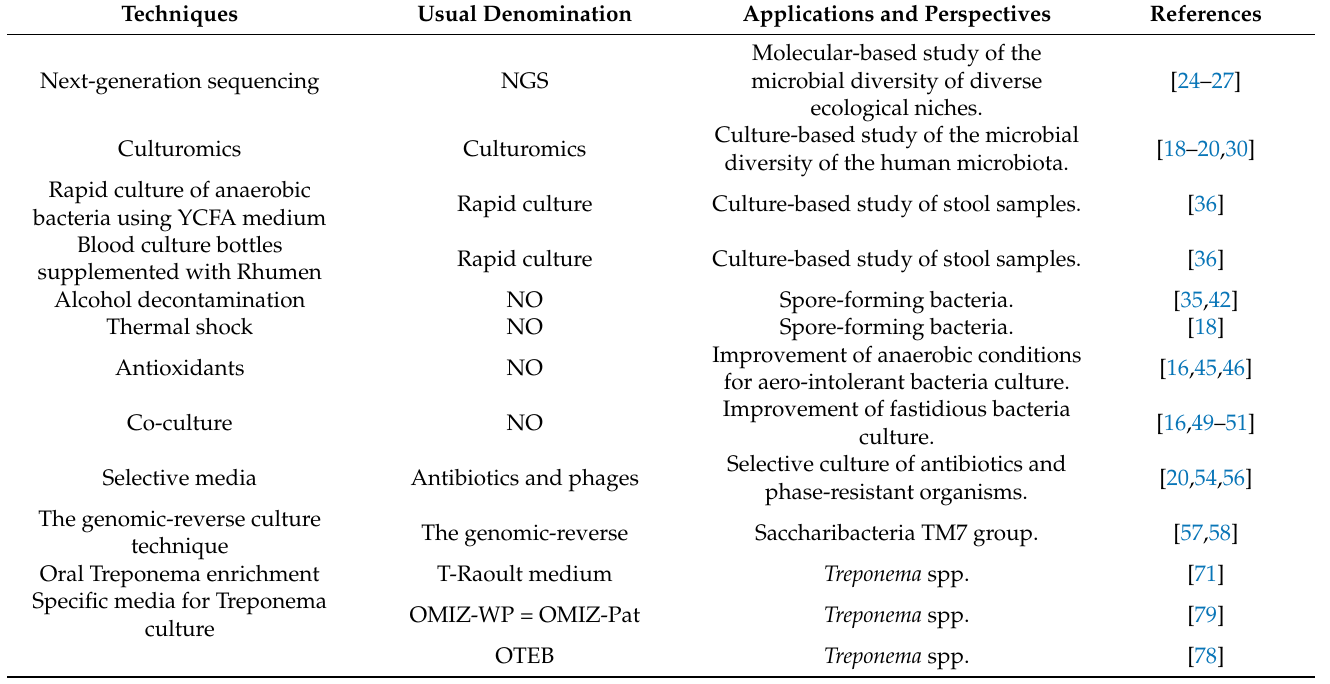
Table 1. Update and description of culture techniques and their research